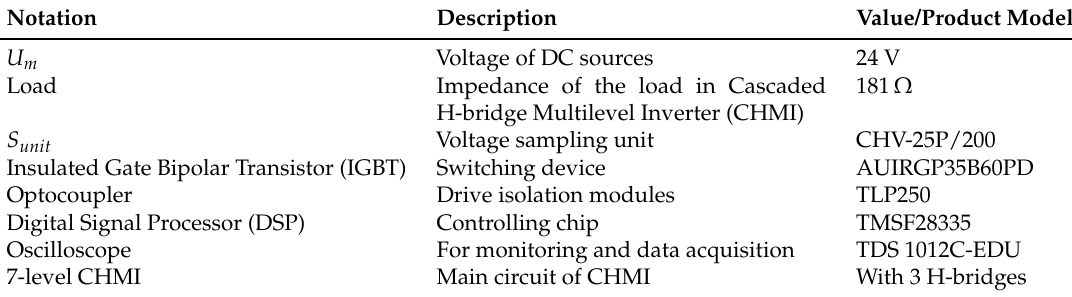
Figure 8. Hardware platform of cascaded H-bridge inverter. Table 2. Main parameters of the